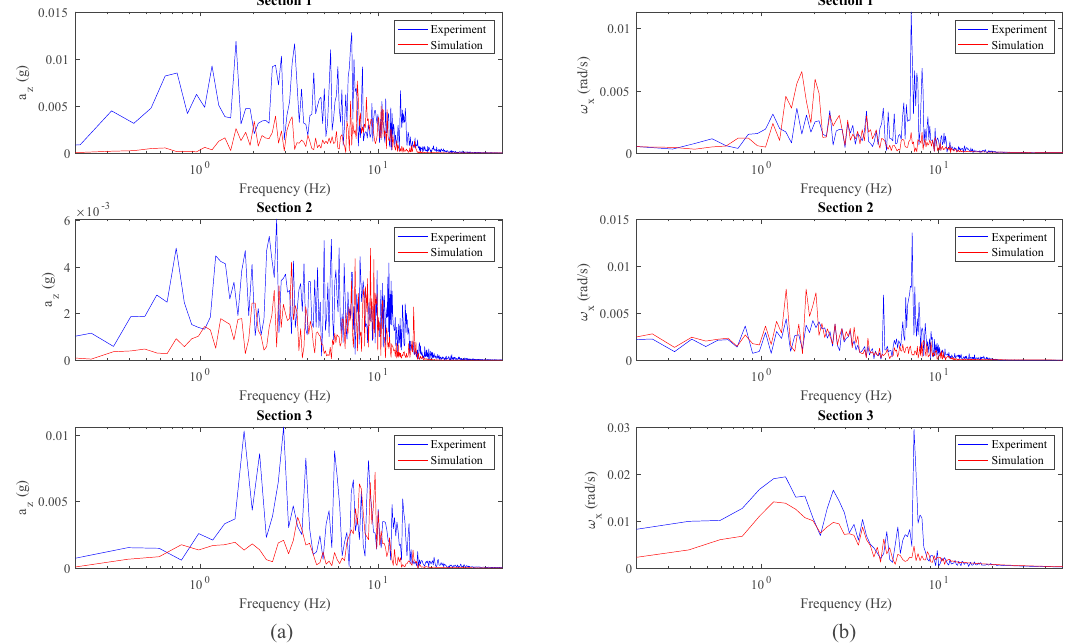
Figure 16. Frequency analysis of vertical acceleration ( a ) and roll angular velocity ( b ) data from inertial sensors on the bogie